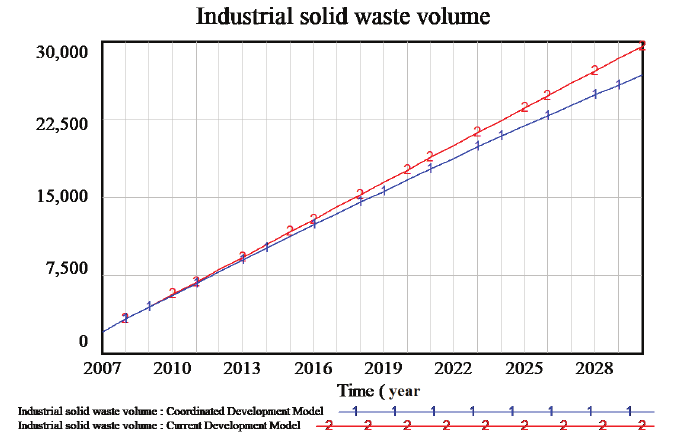
Fig. 8 Industrial solid waste pollution volume simulation value(10,000